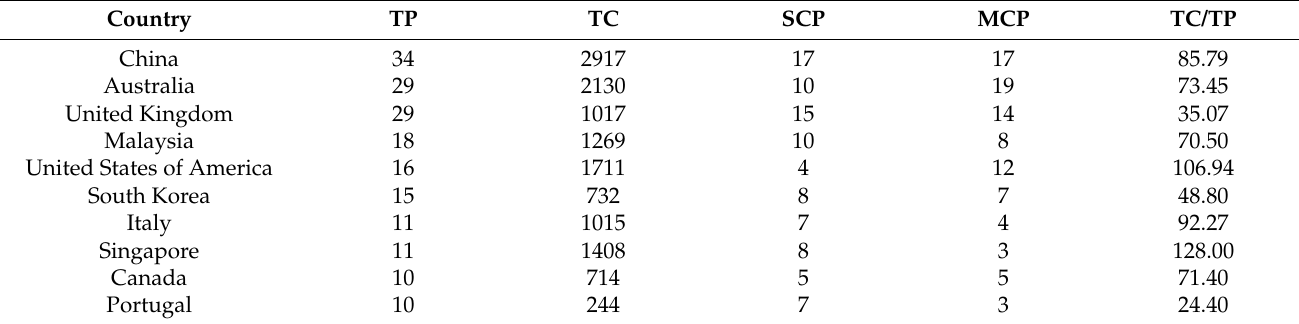
Table 6. Top ten countries that contribute to the topic of C4.0 and